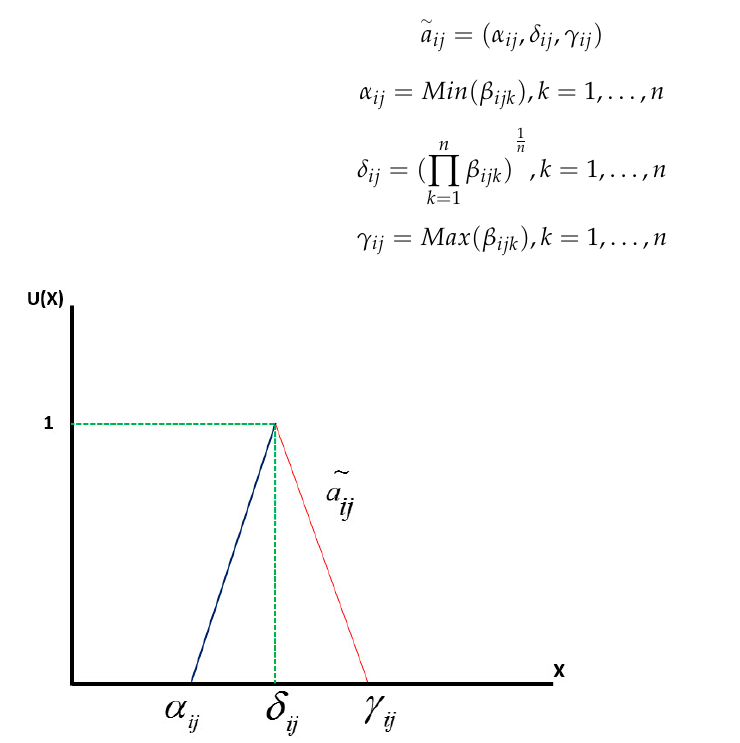
Figure 1. Triangular membership function of fuzzy Delphi method.